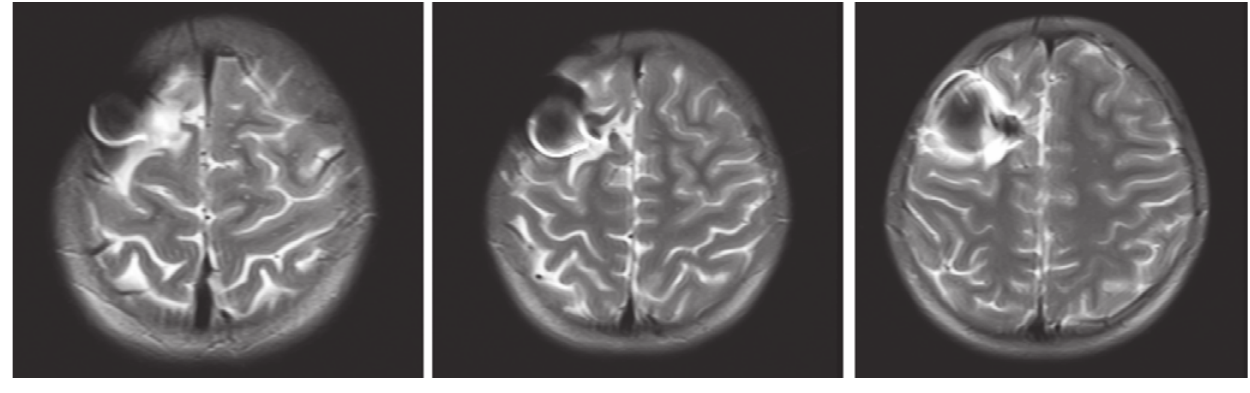
Figure 1. T2-weighted transverse magnetic resonance images show magnetic susceptibility artefact on right frontal